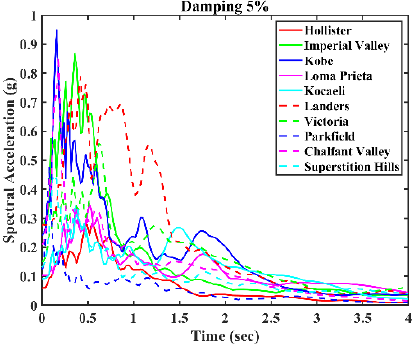
Figure 17. The response spectrum of the selected ground motions.